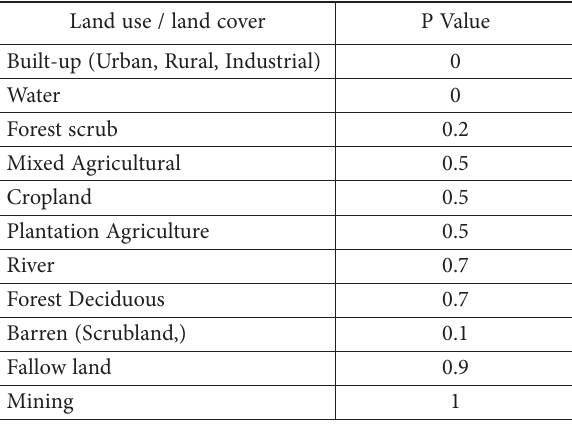
Table 2. Supporting conservation practice factor